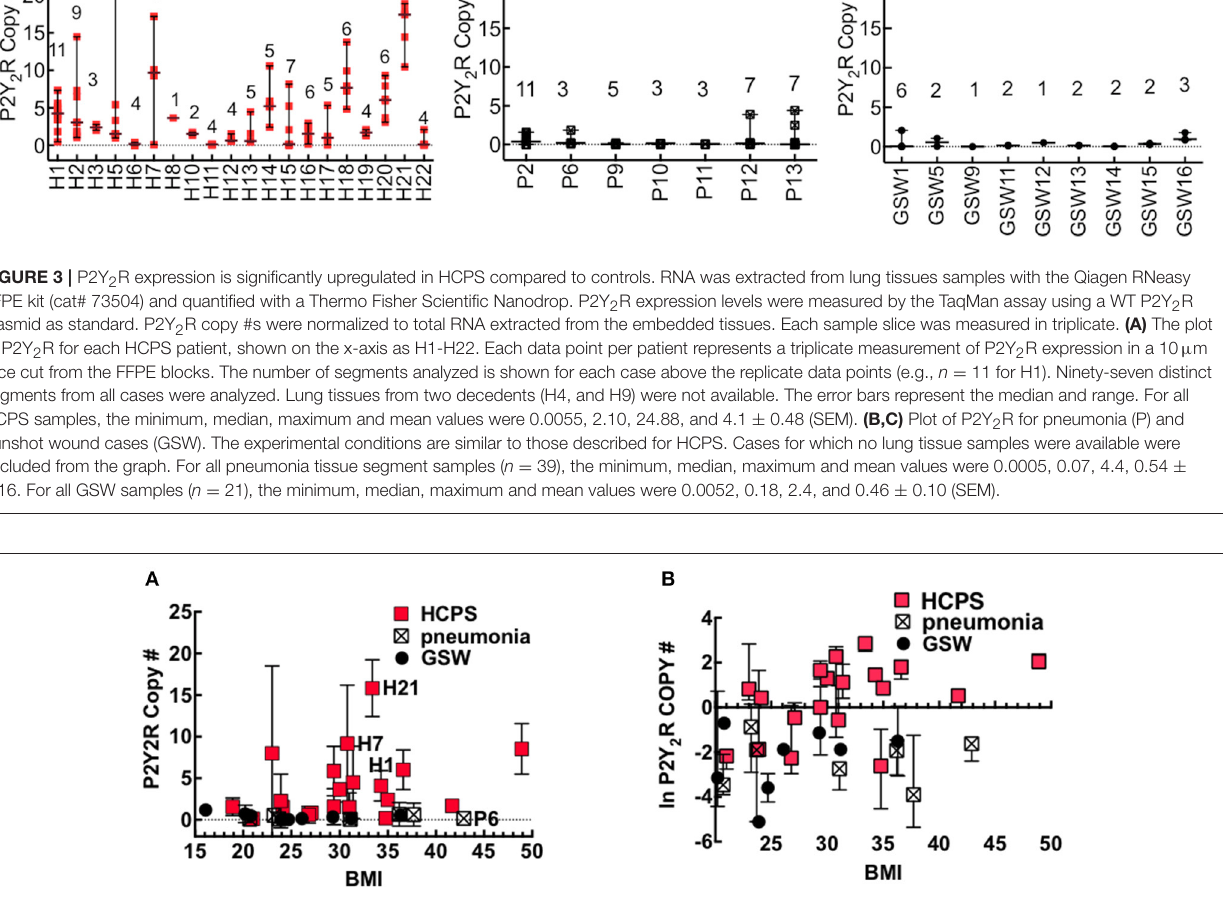
the best predictor of average lung P2Y 2 R expression was type (case or control) ( p = 0.002), followed by BMI ( p = 0.16), when controlling for age and